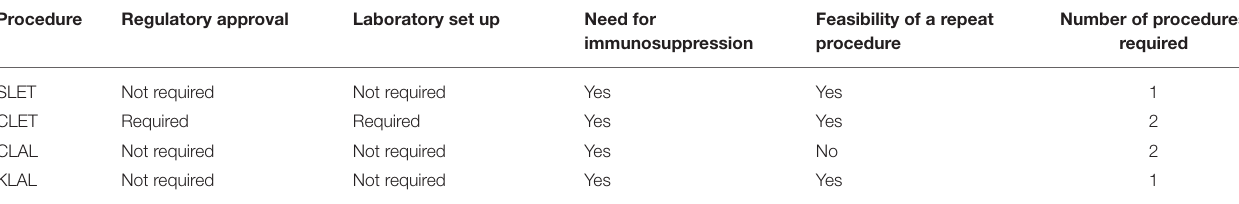
TABLE 5 | Comparison of different allogeneic Limbal stem cell transplantation